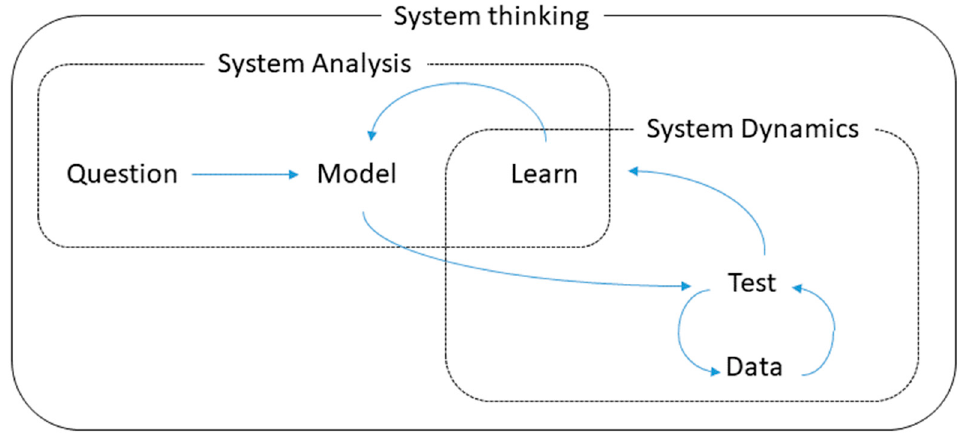
Figure 2. A visual representation of the relationship between system thinking, system analysis, and system dynamics, based on (Haraldsson 2000).